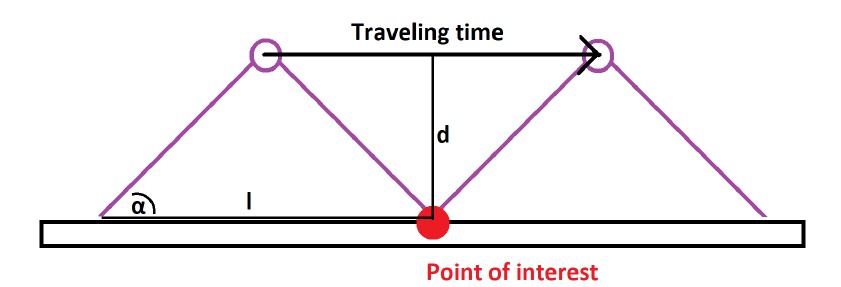
Figure 13. The geometry of robot movement during